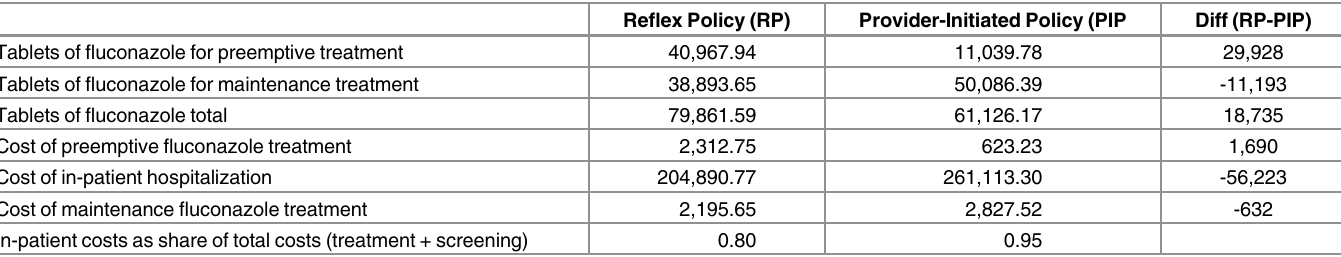
Table 5. Disaggregated costs (2015 USD) and quantity of fluconazole tablets (200 mg) per 1000,000 CD4